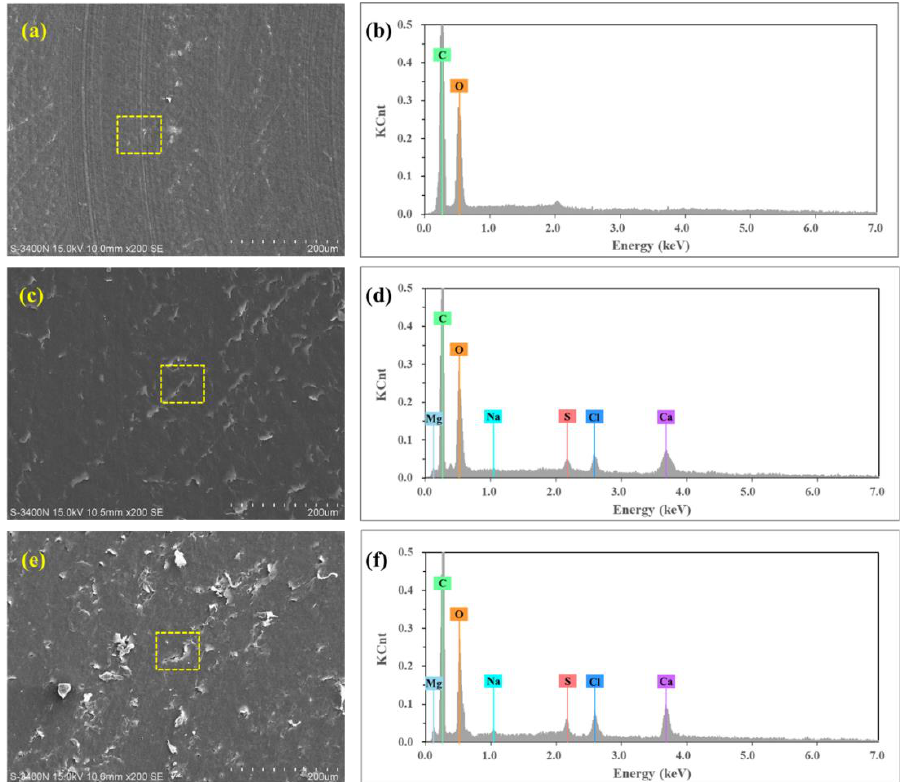
Figure 7. EDS analysis of worn surface of UHMWPE ( a ) water-unsaturated lubrication with 110 N load, ( c ) brine-unsaturated lubrication with 50 N load, and ( e ) brine-unsaturated lubrication with 110 N load; ( b , d , f ) are EDS spectra of the sample surface labeled in ( a , c , e ), respectively.